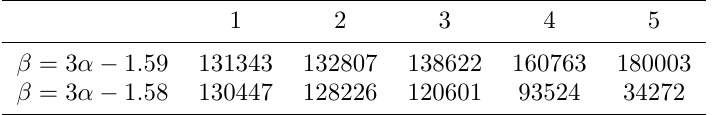
Table 1: Experimental results on the number of reduced signatures L after ρ rounds of the range reduction by Algorithm 3, when α = 15 and S = 2 α +2 = 131072 1 2 3 4 5 β = 3 α − 1 . 59 131343 132807 138622 160763 180003 β = 3 α − 1 . 58 130447 128226 120601 93524